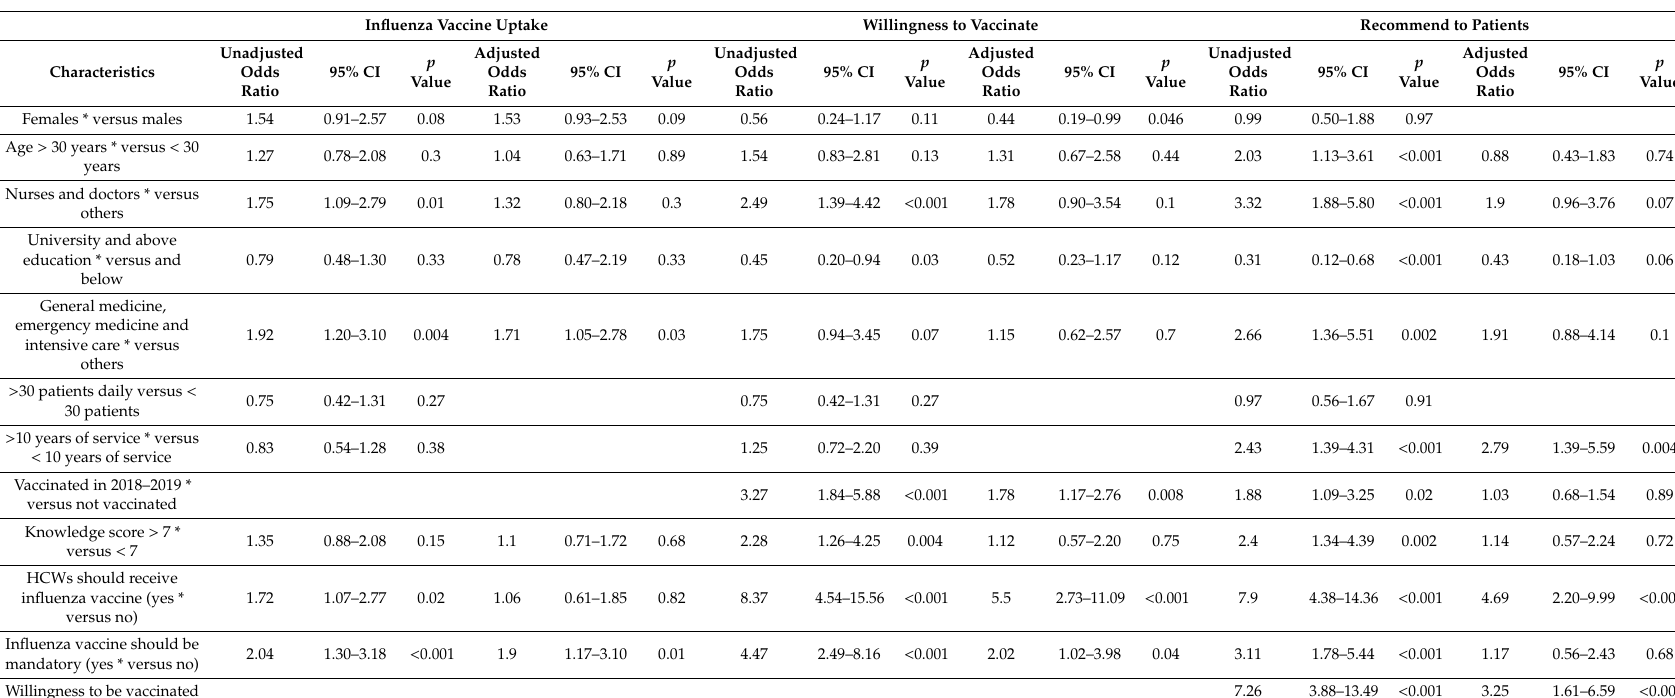
Table 2. The association between socio-demographic factors, knowledge scores and attitudes and influenza vaccine related